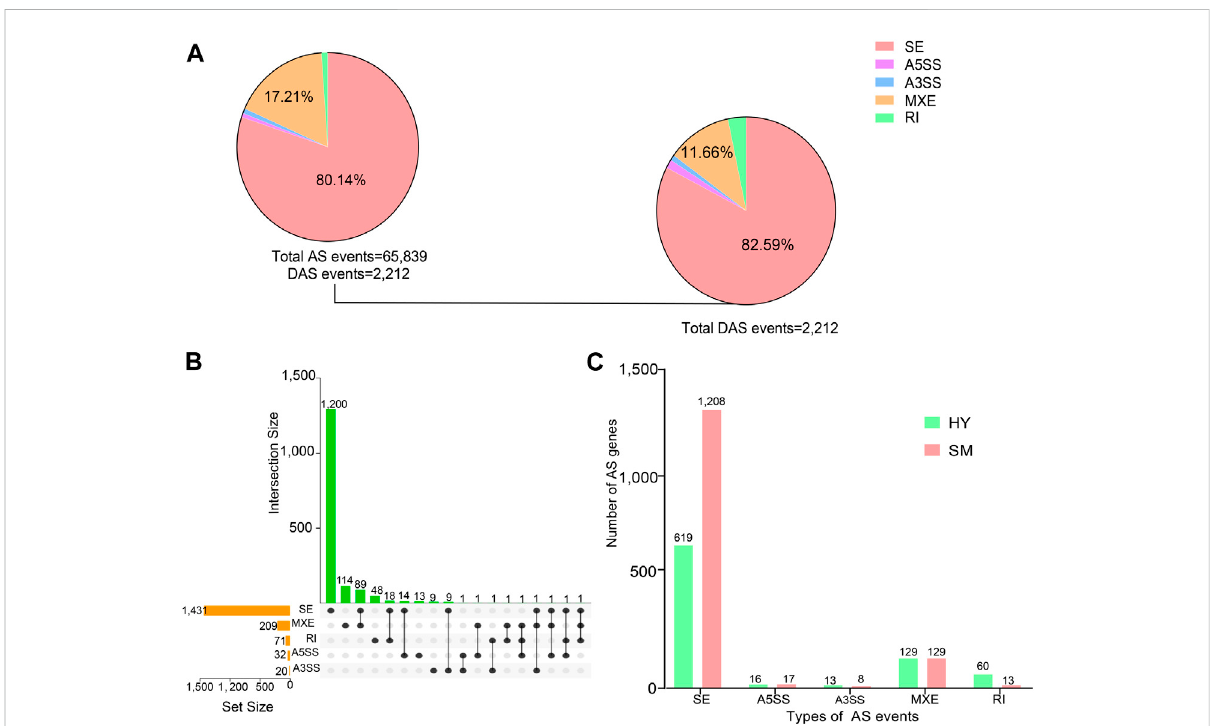
FIGURE 7 Identi fi cation and characterization of total alternative splicing (AS) events and differential AS (DAS) events. (A) Distribution of fi ve AS types including skipping exon (SE), alternative 5 ′ splice site (A5SS), alternative 3 ′ splice site (A3SS), mutually exclusive exon (MXE), and retained intron (RI) among 65,839 AS events and 2,212 unique DAS events ( FDR < 0.05). (B) Statistical results of shared and speci fi c AS events in two groups. The bar graph on the left shows the number of raw AS events. The connections between points indicated the presence of intersections between corresponding data sets. (C) The number of fi ve AS event genes in the healthy and subclinical mastitis